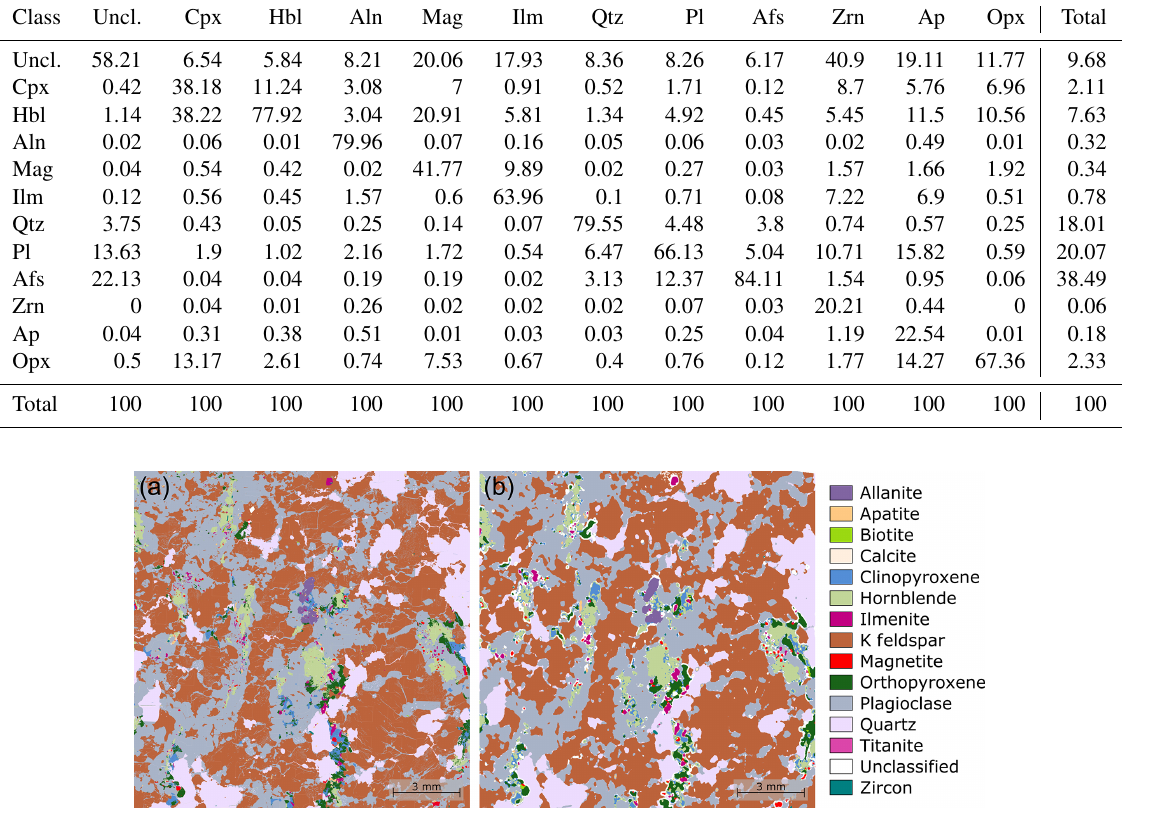
Table 4. Error matrix in percent for sample 342 with the MLA as reference data in the columns and the µ-EDXRF in lines with mineral abbreviations as follows: unclassified, Uncl.; clinopyroxene, Cpx; hornblende, Hbl; allanite, Aln; magnetite, Mag; ilmenite, Ilm; quartz, Qtz;